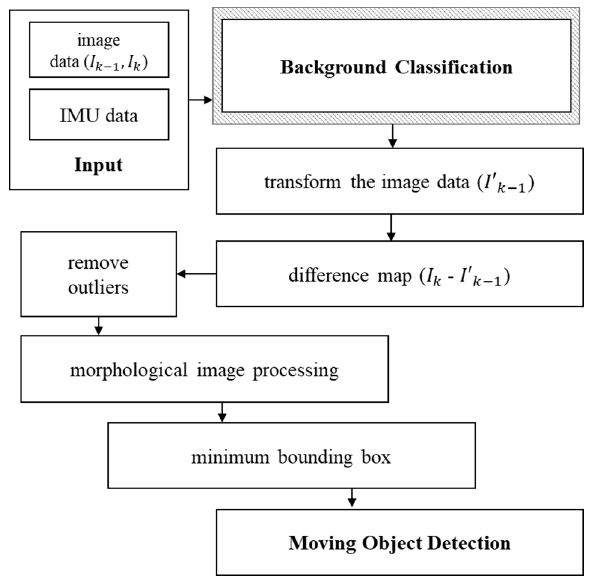
Figure 1. Overview of the proposed moving object detection method.